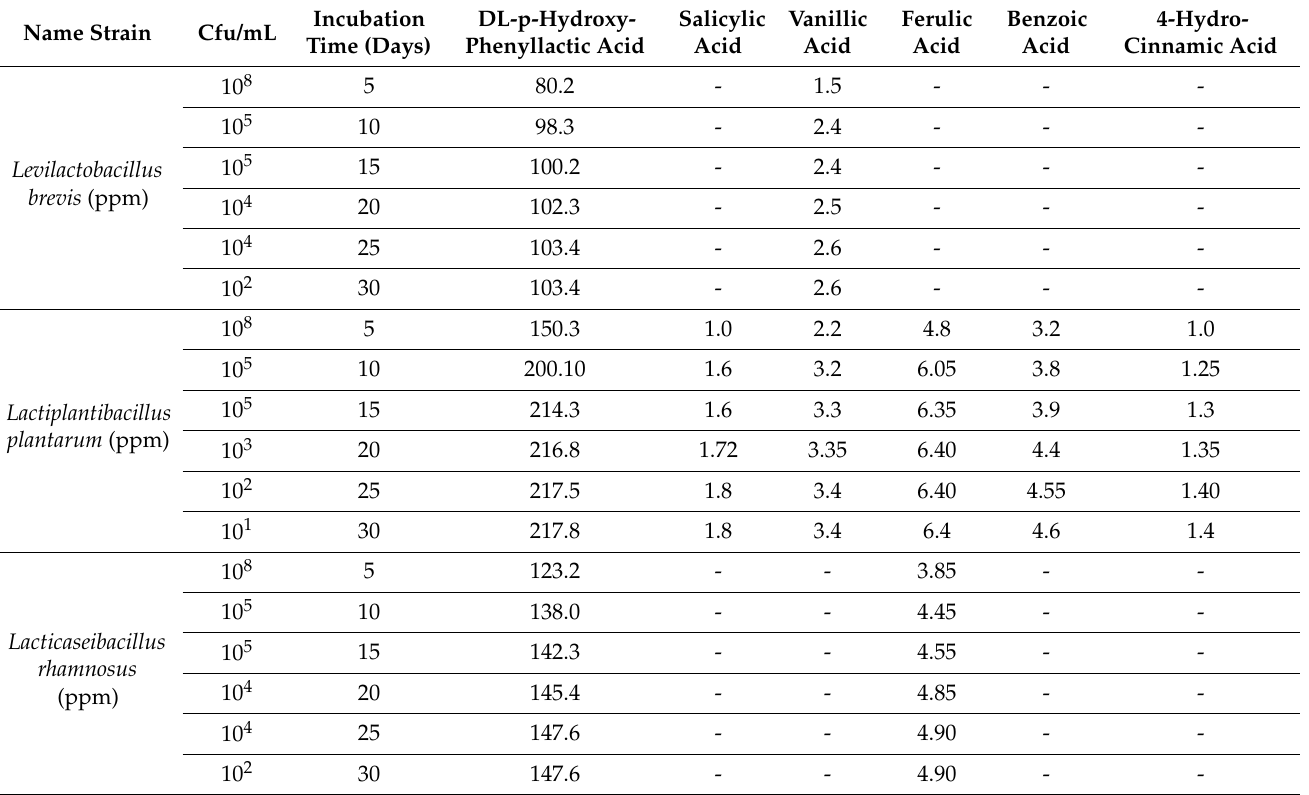
Table 3. Concentration (in ppm) of metabolites produced by Levilactobacillus brevis, Lactiplantibacillus plantarum and Lacticaseibacillus rhamnosus